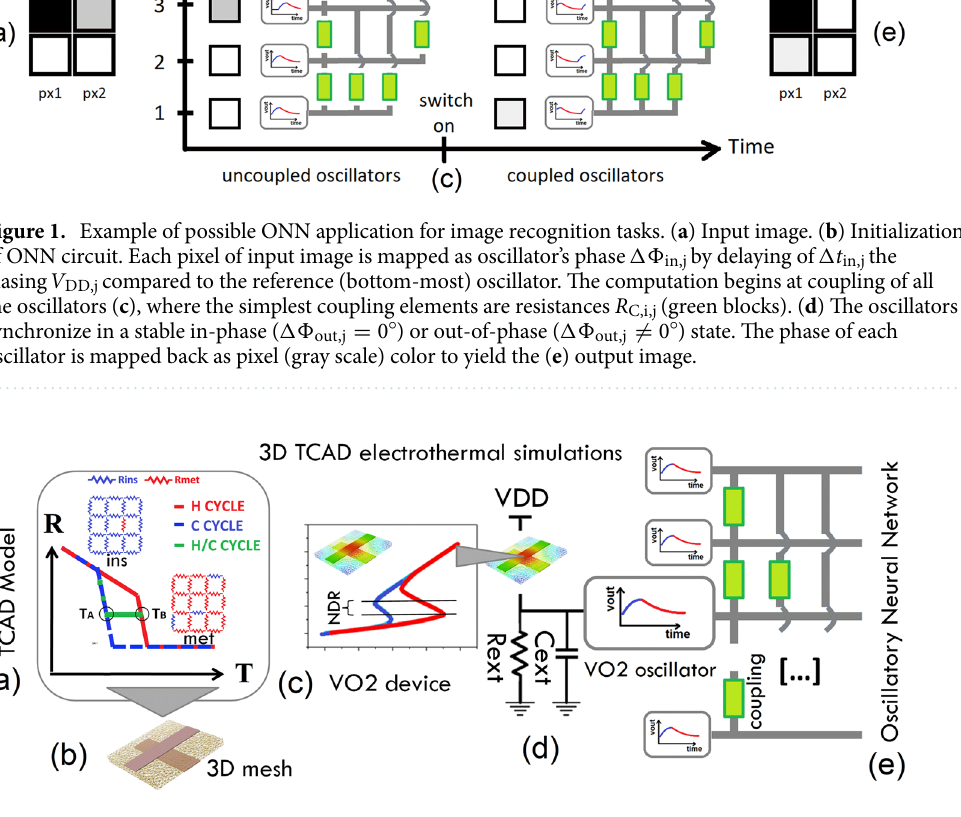
Figure 2. ( a ) Temperature-triggered resistive switching of VO 2 volatile memristor. ( b ) 3D mesh of VO 2 CB device. ( c ) TCAD simulated I – V D characteristics. The associated NDR region has been highlighted. ( d ) Scheme of VO 2 oscillator circuit. Self-oscillatory electrical behavior is associated to a suitable choice of the load-line. ( e )